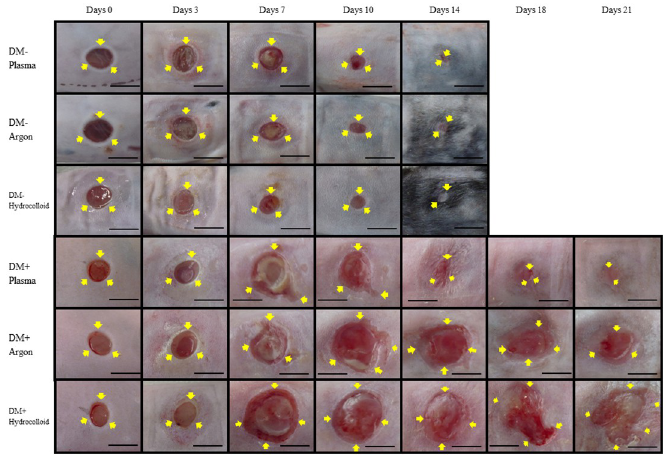
Fig 6. Wound healing observations in normal and diabetic mice. Wounds of 4 mm in diameter were made on the dorsum, and healing was recorded by photography. The wound edge is indicated by arrows. Bar, 5 mm.